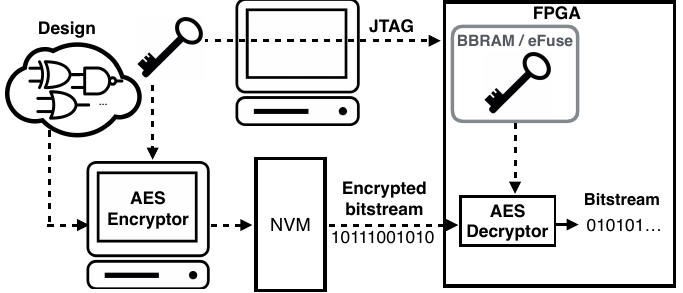
Figure 4: Encrypting the bitstream in the IDE using a key and decrypting it on the FPGA by an ASIC decryption core using the same